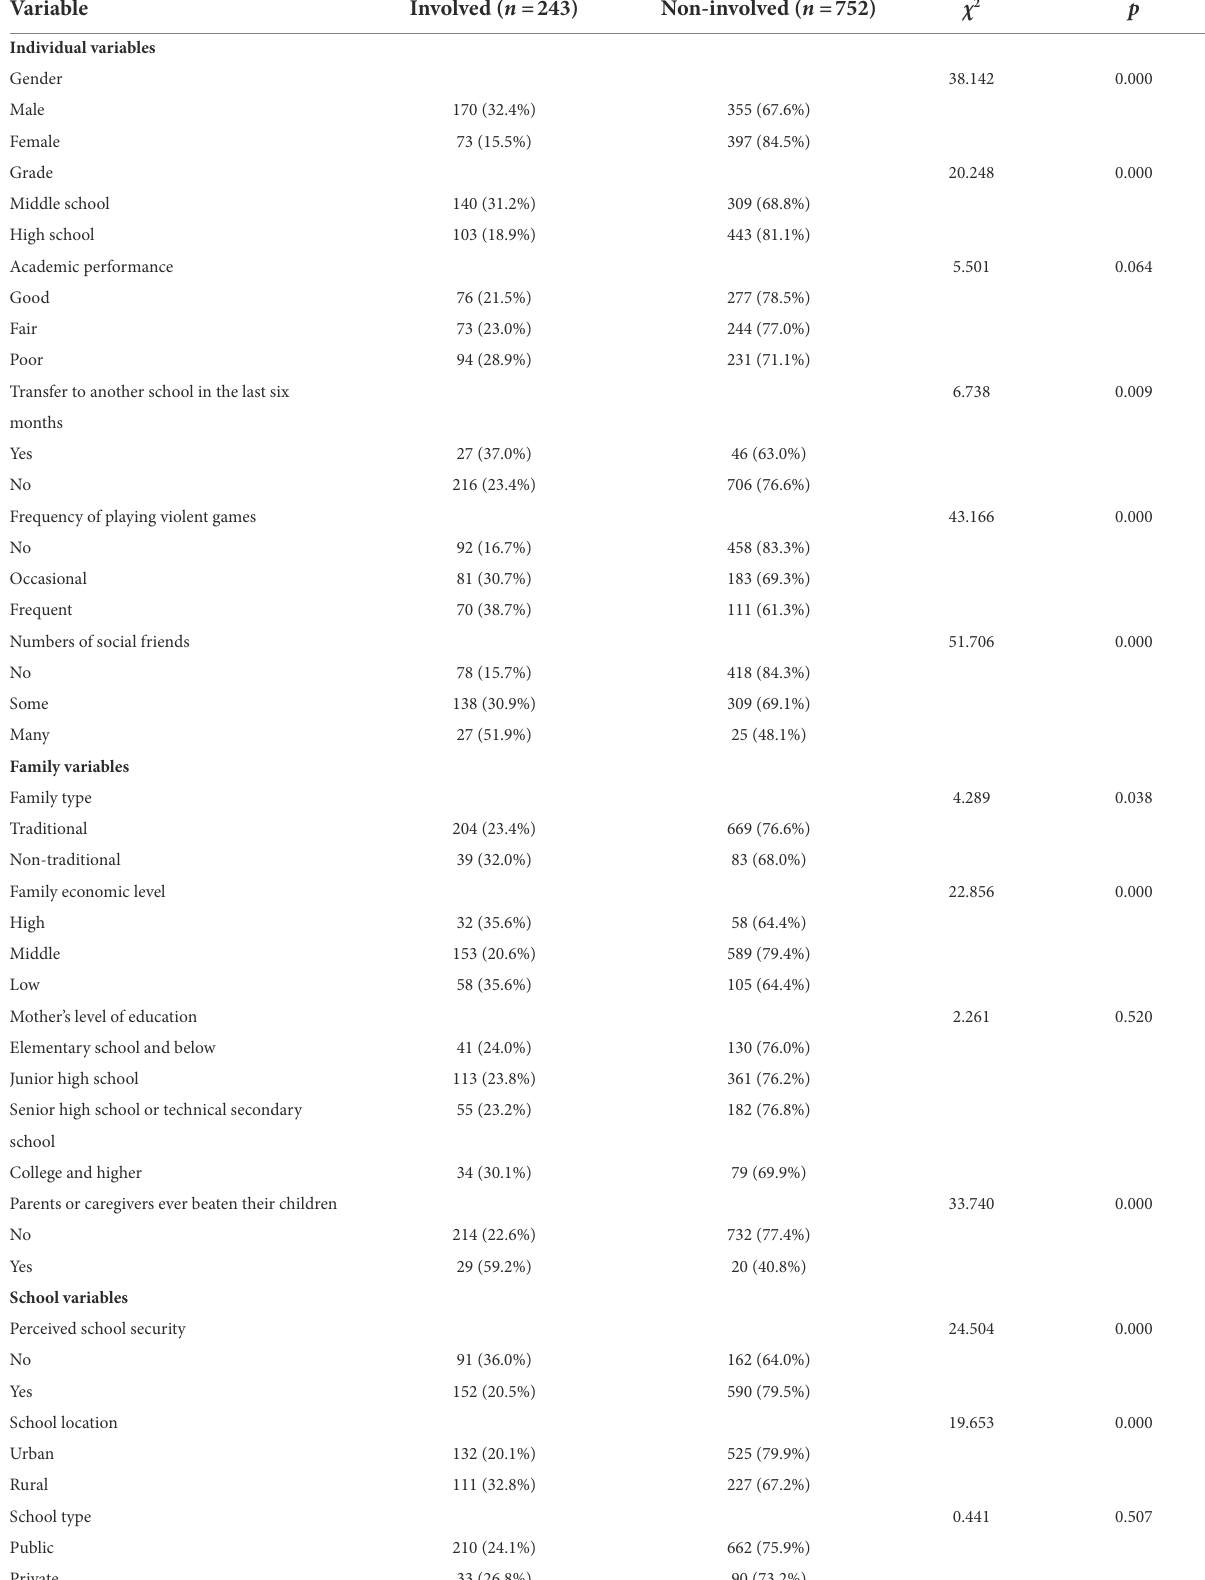
TABLE 3 Risk factors related to school bullying in migrant children ( n = 995). Variable Involved ( n =